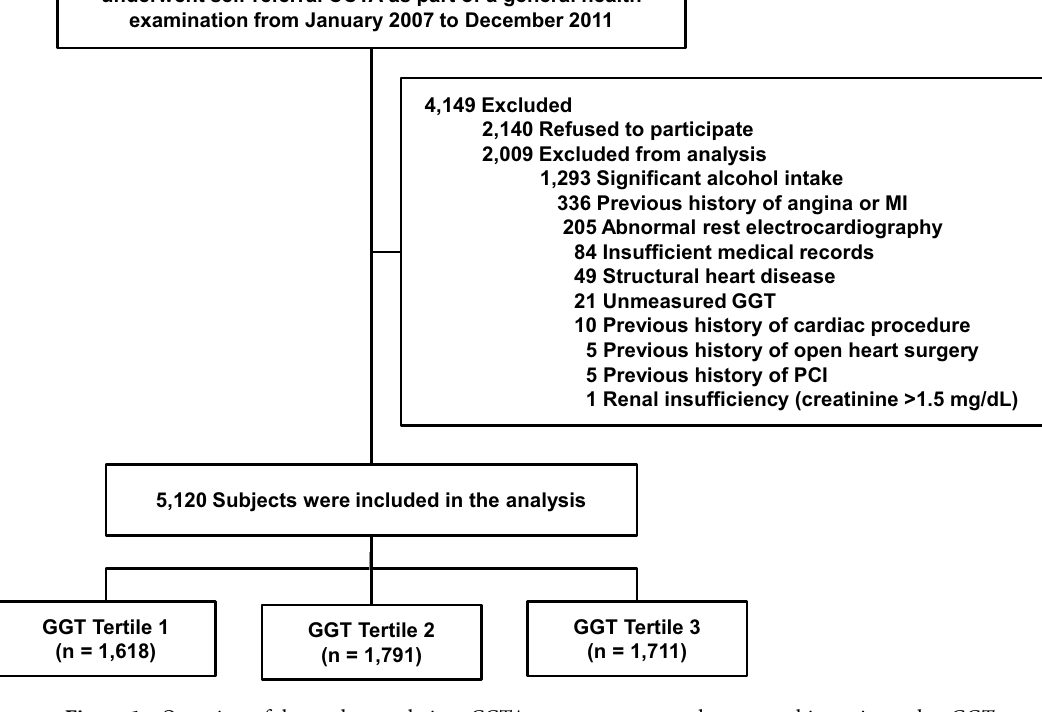
Figure 1. Overview of the study population. CCTA coronary computed tomographic angiography; GGT gamma-glutamyl transferase; MI myocardial infarction; PCI percutaneous coronary